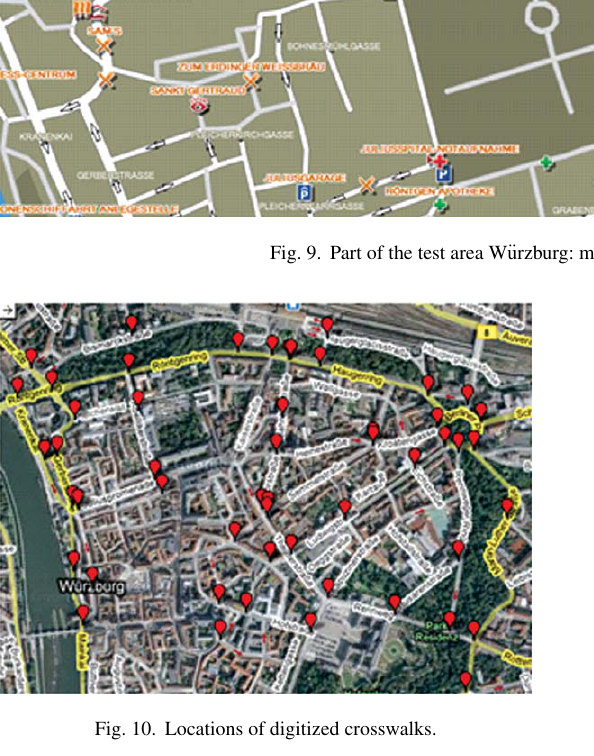
Fig. 11. Locations of virtual connections.